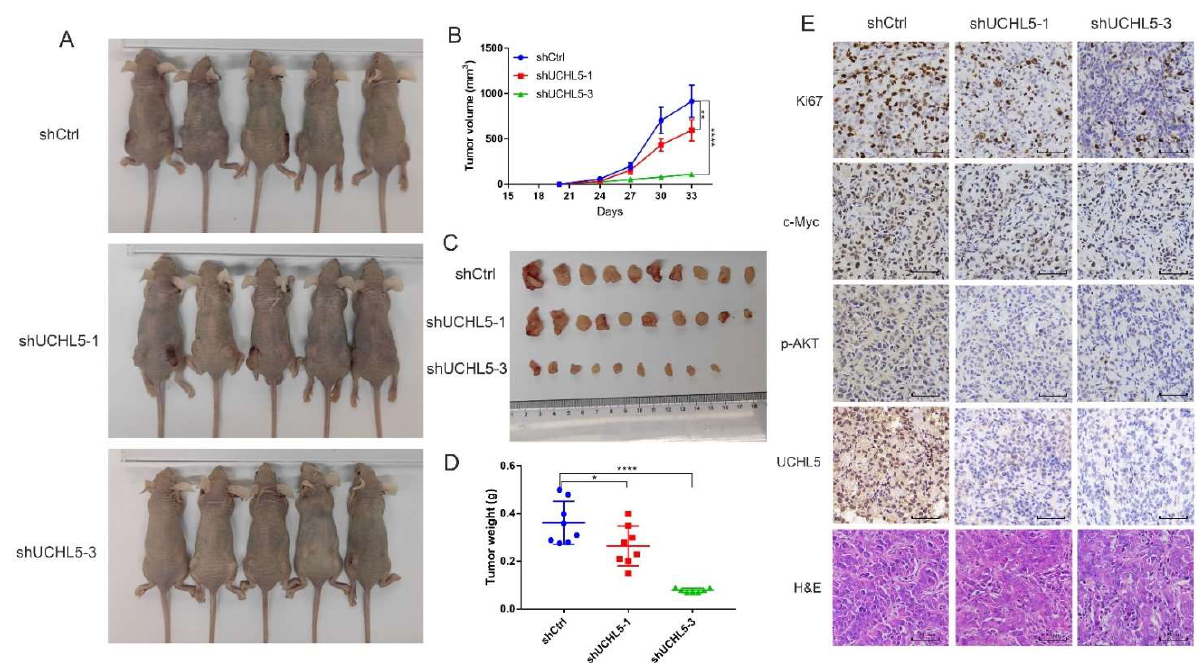
Figure 7. The depletion of UCHL5 inhibits bladder cancer tumorigenesis in vivo. ( A ) Xenograft models ( n = 5) were established by subcutaneously inoculating shCtrl or shUCHL5 cells and allowing the cells to grow for five weeks. The mice were then sacrificed, and the tumors were removed and weighed. ( B – D ) The tumor volume and weight measurements are shown. ( E ) Representative H&E staining and immunohistochemical staining of the xenograft tumors from the tumor-bearing mice in the shCtrl and shUCHL5 groups showed the expression of UCHL5, p-AKT, c-Myc, and Ki67 decreased in the shUCHL5 group compared with the shCtrl group. All scale bars = 50 μm. Statistical analysis of the tumor volume and weight were performed using one-way ANOVA. Values are shown as mean ± SD. * p < 0.05, ** p < 0.01, and **** p < 0.0001 compared with controls.